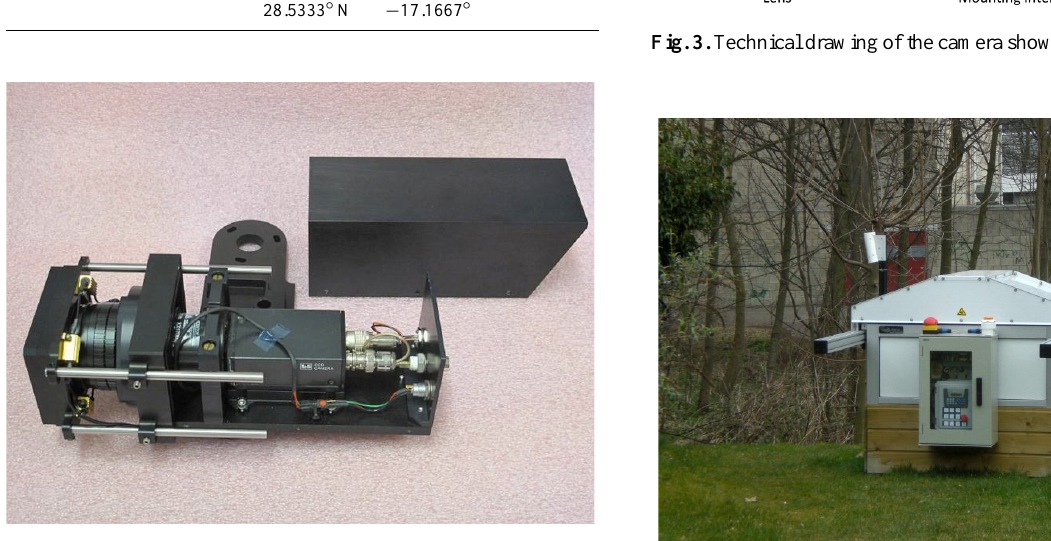
Fig. 2. Photograph of one of the intensified video cameras. The protective cover is removed and visible in the back. The camera is shown with the optional grating holder on the left side. Power resistors to heat the grating can be seen on the left.